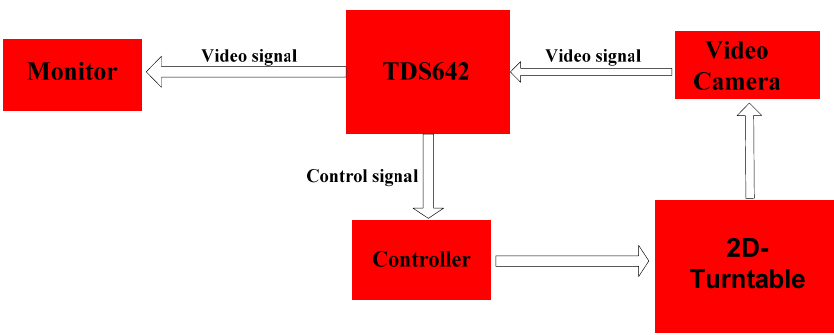
Figure 1. The target tracking system structure